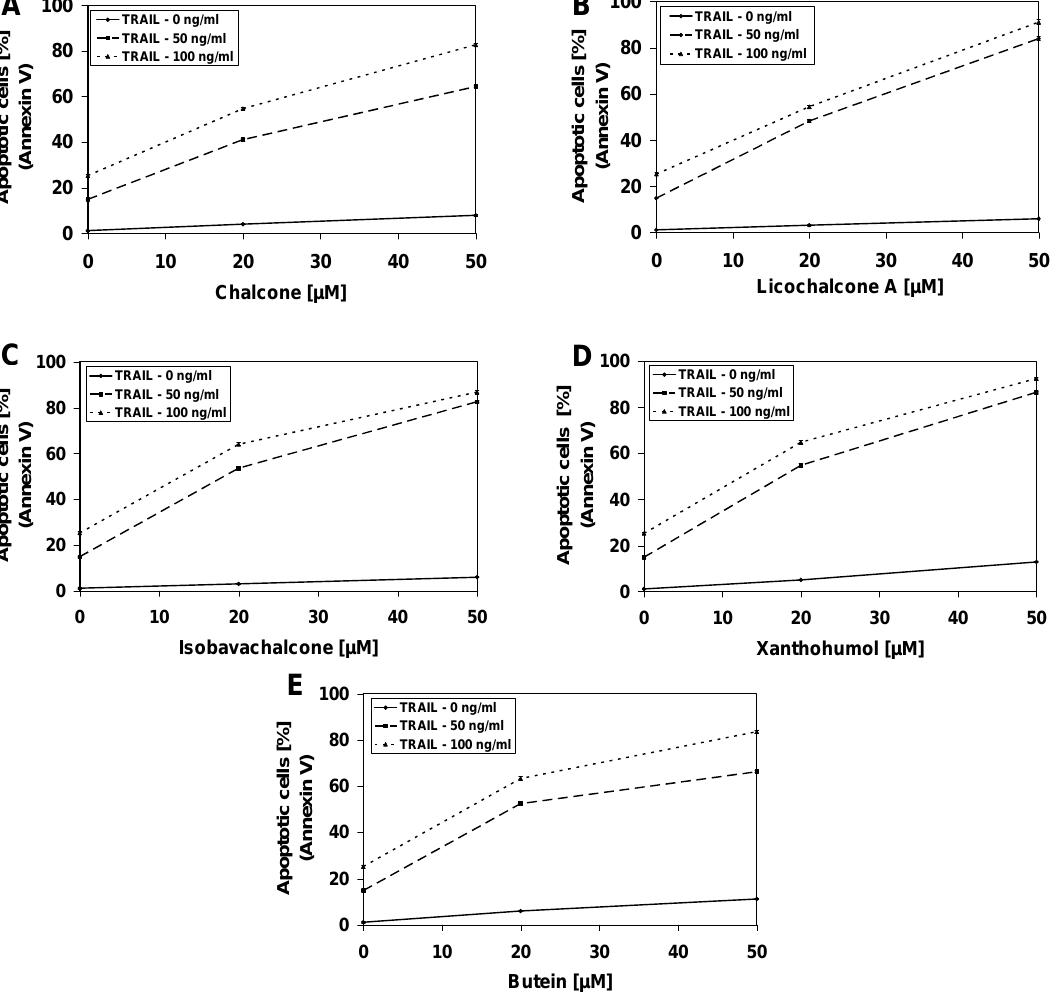
Figure 5. TRAIL induced apoptosis in combination with chalcones in LNCaP prostate cancer cells. The cancer cells were incubated for 48 hours with TRAIL at the concentrations of 50 ng/ml and 100 ng/mL and chalcones: (A) chalcone, (B) licochalcone-A, (C) isobavachalcone, (D) xanthohumol and (E) butein at the concentrations of 20 μ M and 50 μ M. Detection of apoptotic cell death by annexin V-FITC staining using flow cytometry. The values represent mean ± SD of three independent experiments performed in duplicate (n = 6) (p <